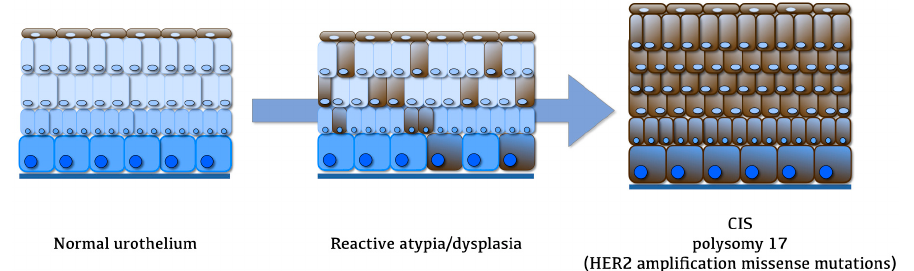
Figure 1. Differential HER2 expression in flat urothelial lesions. CIS: carcinoma in situ.